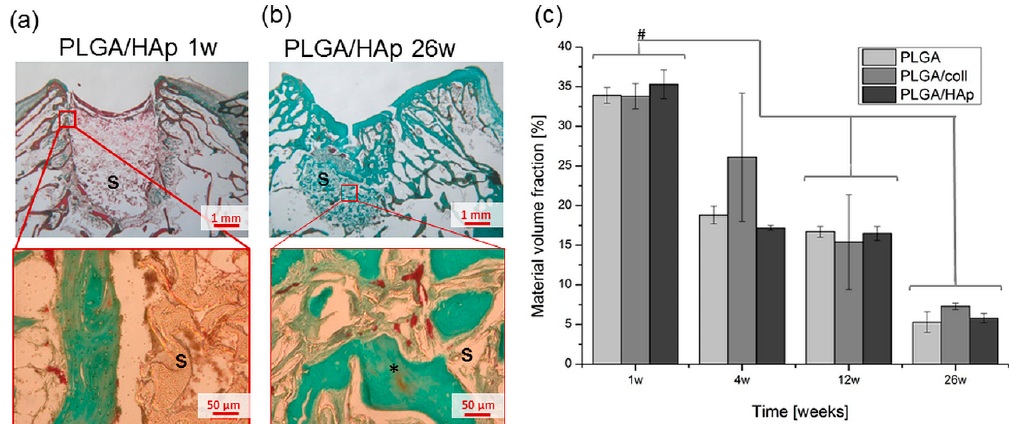
Figure 6. Histological analysis after Masson–Goldner staining of PLGA / HAp scaffold 1 week post-implantation ( a ) and PLGA / HAp scaffold 26 weeks post-implantation ( b ); s—scaffold, star (*)—tissue ingrowth. Material volume fraction of PLGA, PLGA/coll and PLGA/HAp scaffolds at the implantation site after 1, 4, 12 and 26 weeks post-implantation ( c ); statistically significant differences at # p < 0.05 according to ANOVA.